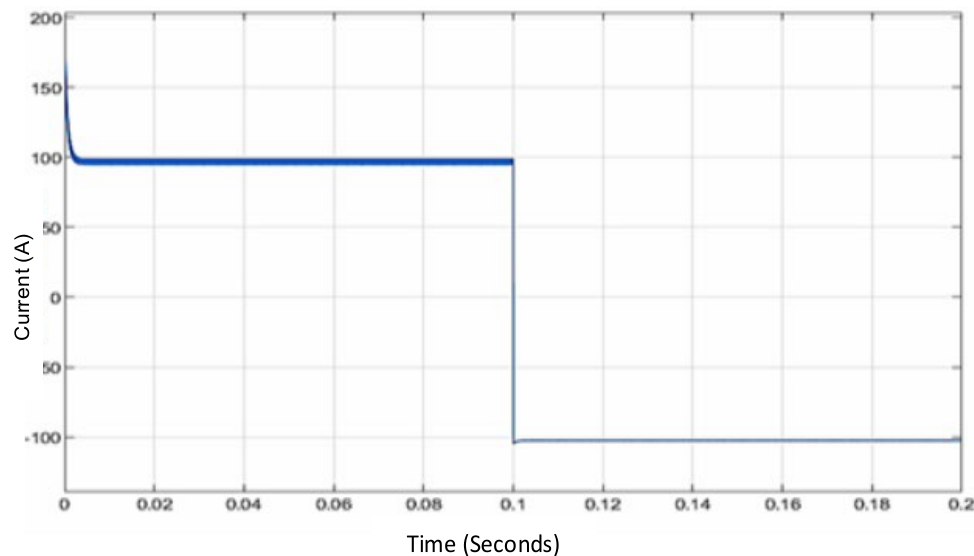
Figure 14. Current across the DCSOP, showing control of the current flow direction.